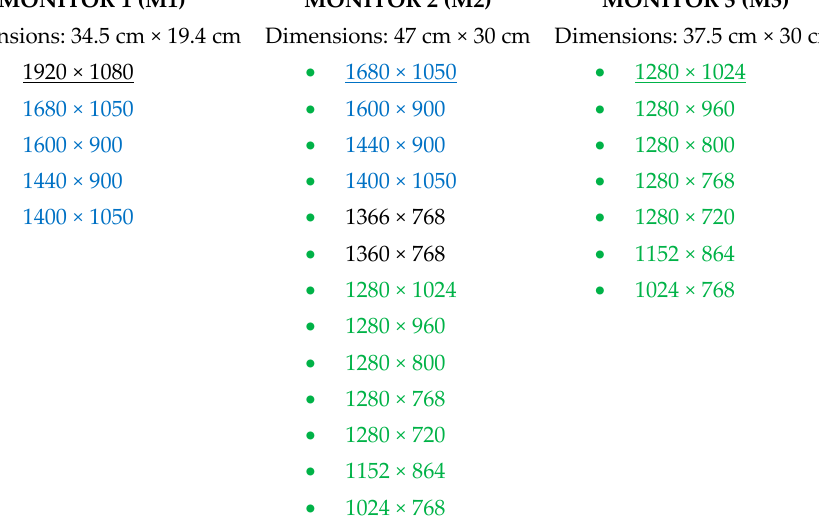
Figure 3. Specifications of the three monitors used in the experimental study.